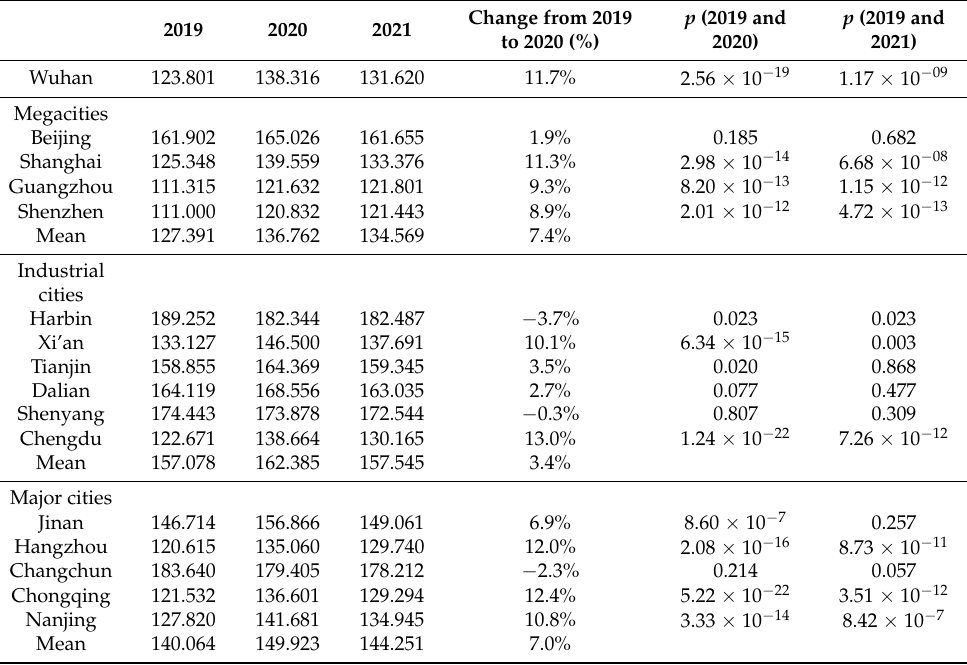
Table 4. Summary of O 3 concentration amount (mmol/m 2 ), temporal changes, and non-parametric Wilcoxon test results among different